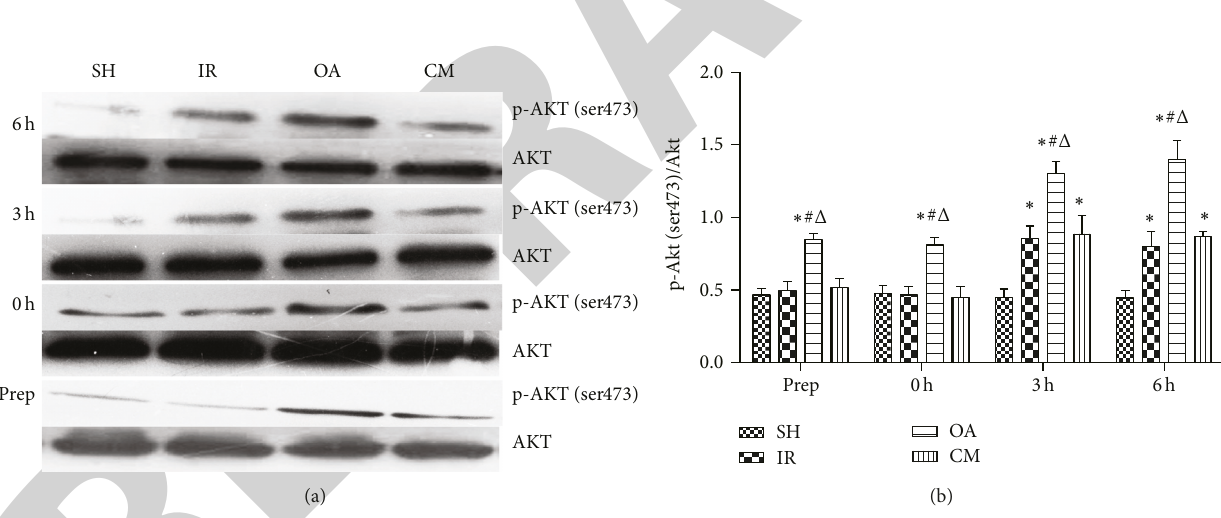
Figure 4: Effects of pretreatment with OA on p-PI3K (p85 𝛼 ) protein expression in rats induced by partial hepatic IR. Expression of p-PI3K (p85 𝛼 ) protein was detected by western blot analysis (a). The GAPDH protein expression was determined as the internal standard. These bands were quantified and analyzed (b). Data are represented as means ± SD ( 𝑛 = 8 ). ∗ 𝑃 < 0.05 , compared with group SH. # 𝑃 < 0.05 , compared with group IR. Δ 𝑃 < 0.05 , compared with group CM.